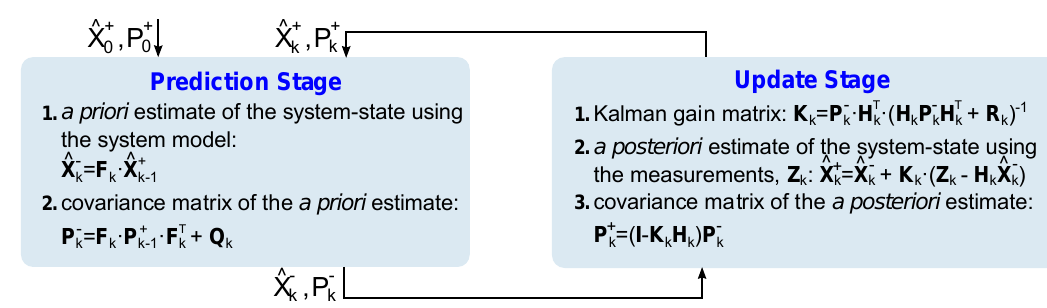
Figure 5. Stage diagram of the Kalman filtering